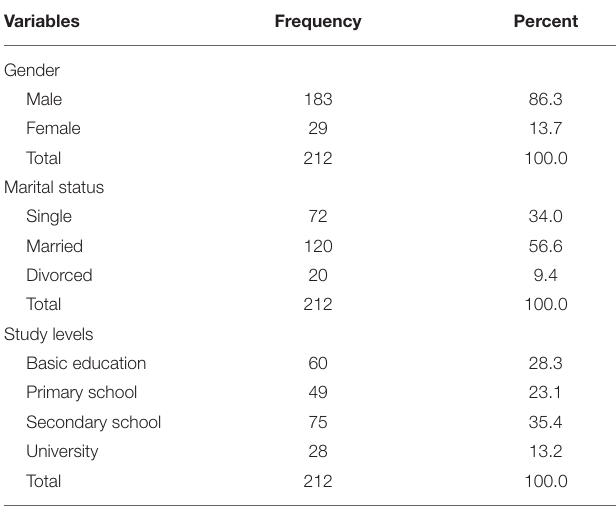
TABLE 1 | Sociodemographic variables of